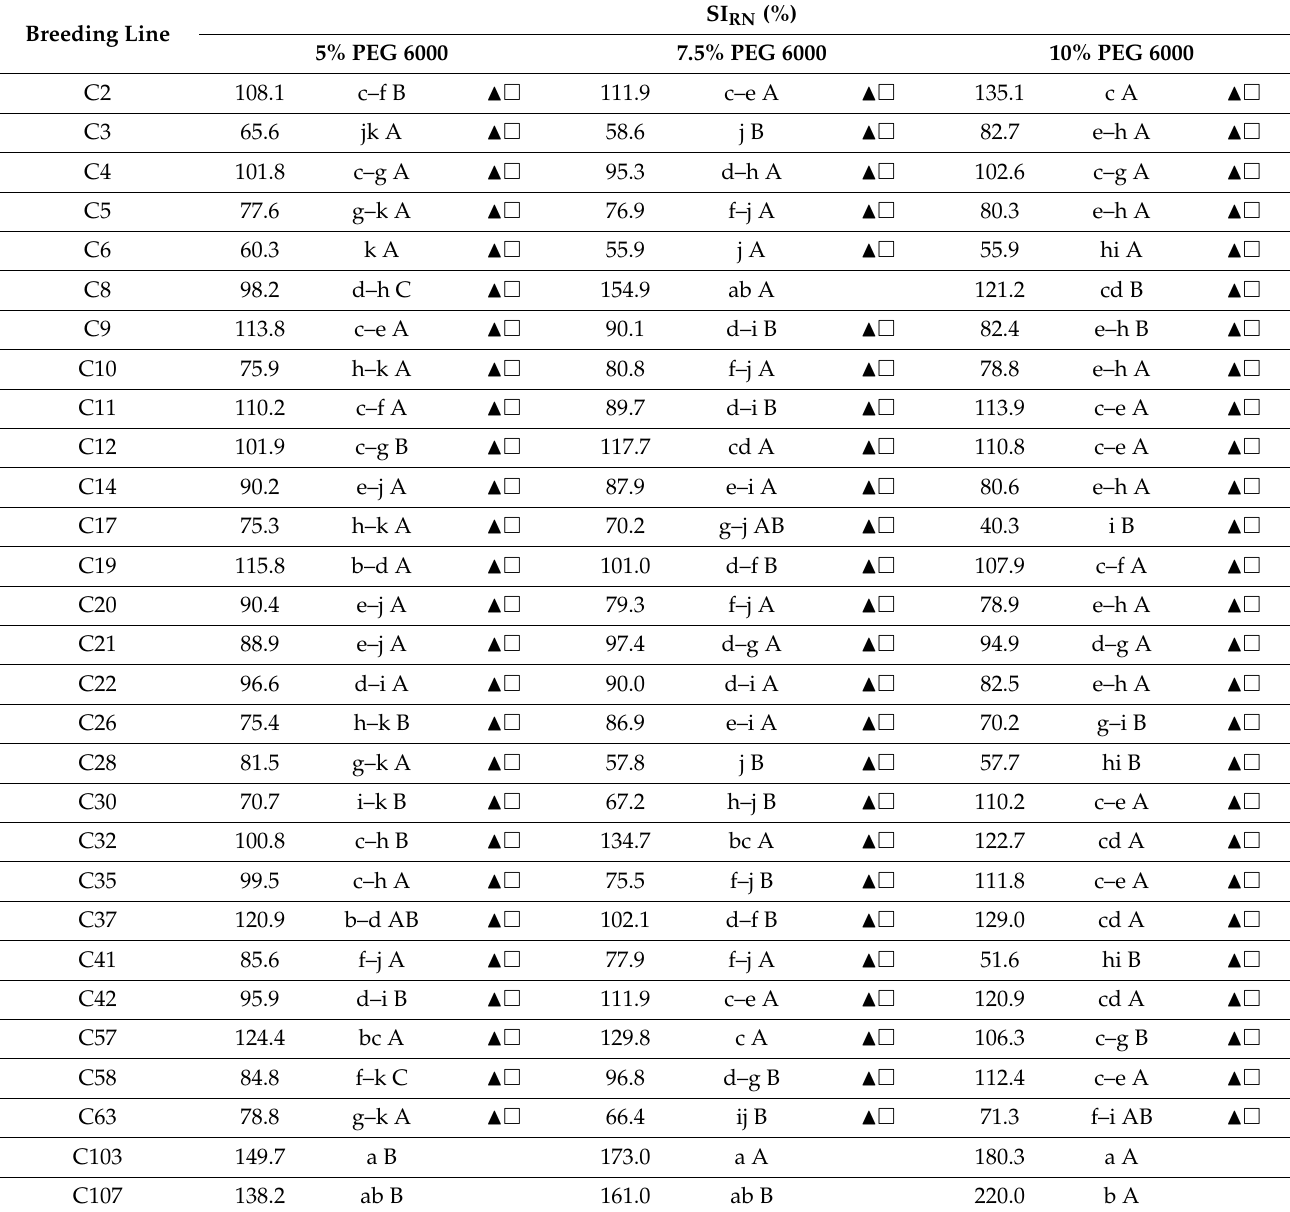
Table 5. Root number SI (SI RN ) values of potato genotypes under osmotic stress induced by PEG 6000 added to the medium at levels of 5.0%, 7.5% and